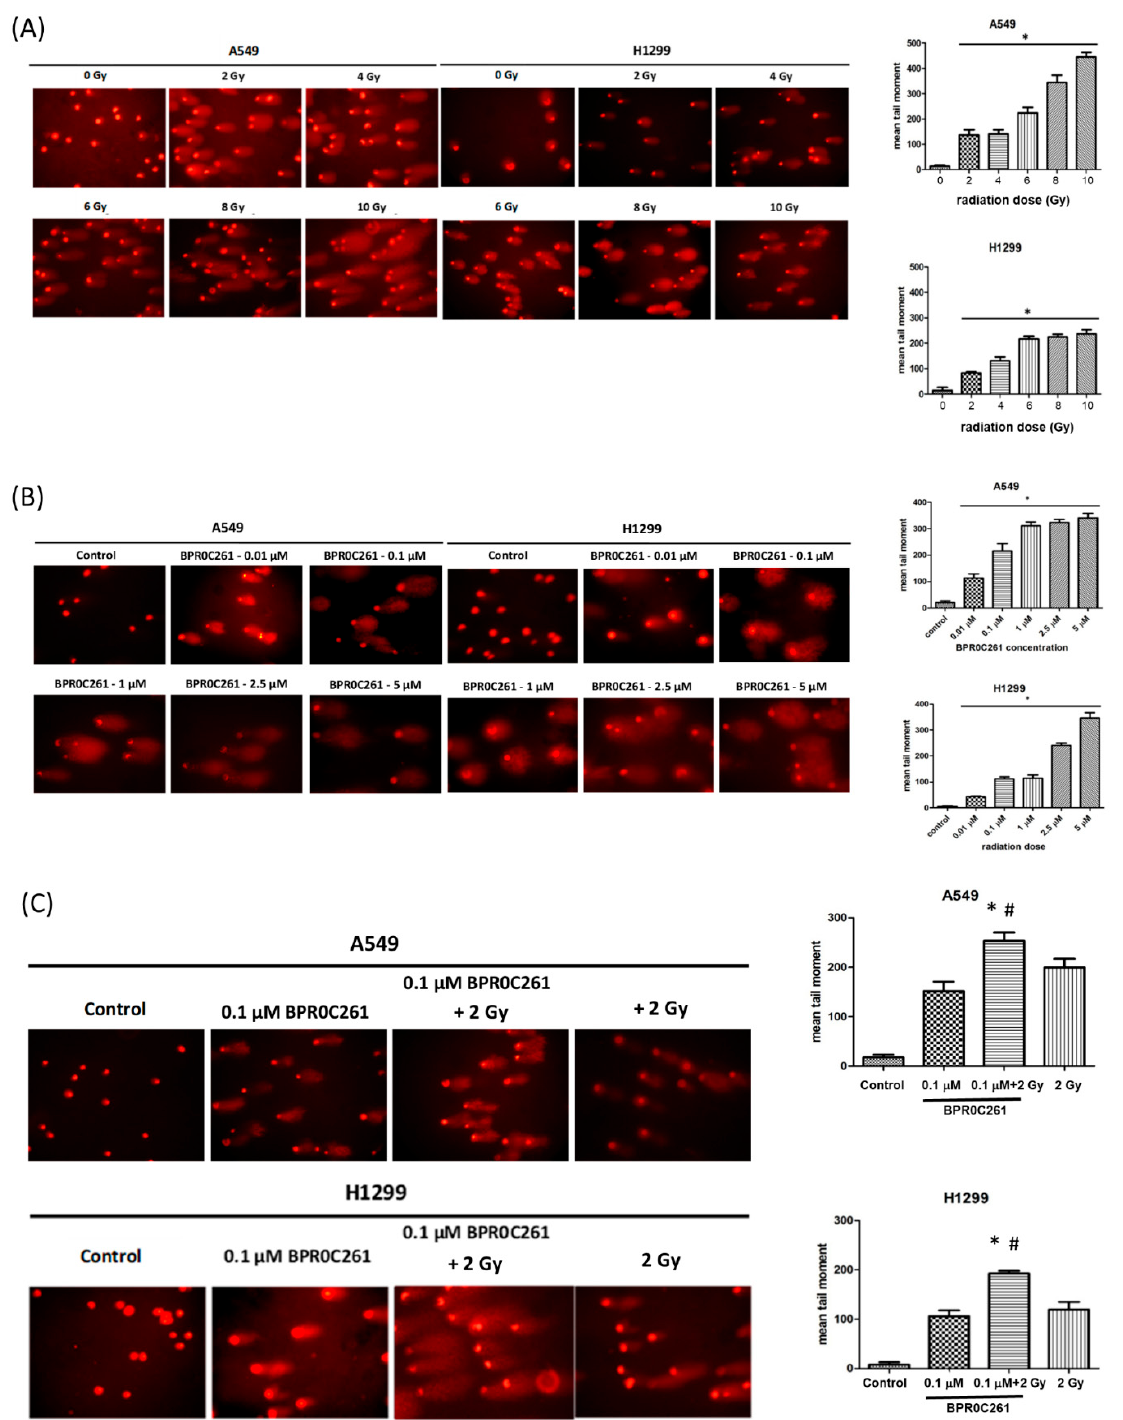
Figure 5. Analysis of DNA damage in NSCLC cells using the comet assay. The images of DNA damage in A549 cells and H1299 cells exposed to ( A ) different doses of X-rays and ( B ) increased concentrations of BPR0C261. The level of DNA damage was quantified by measuring the tail moments. ( C ) Comparison of DNA damage induced by a combination of low concentration of BPR0C261 and 2 Gy X-rays, and individual treatment alone. The microscopic magnification for visualization of comets were 20 × . *: p < 0.05 compared with BPR0C261 alone. #: p < 0.05 compared with radiation alone.